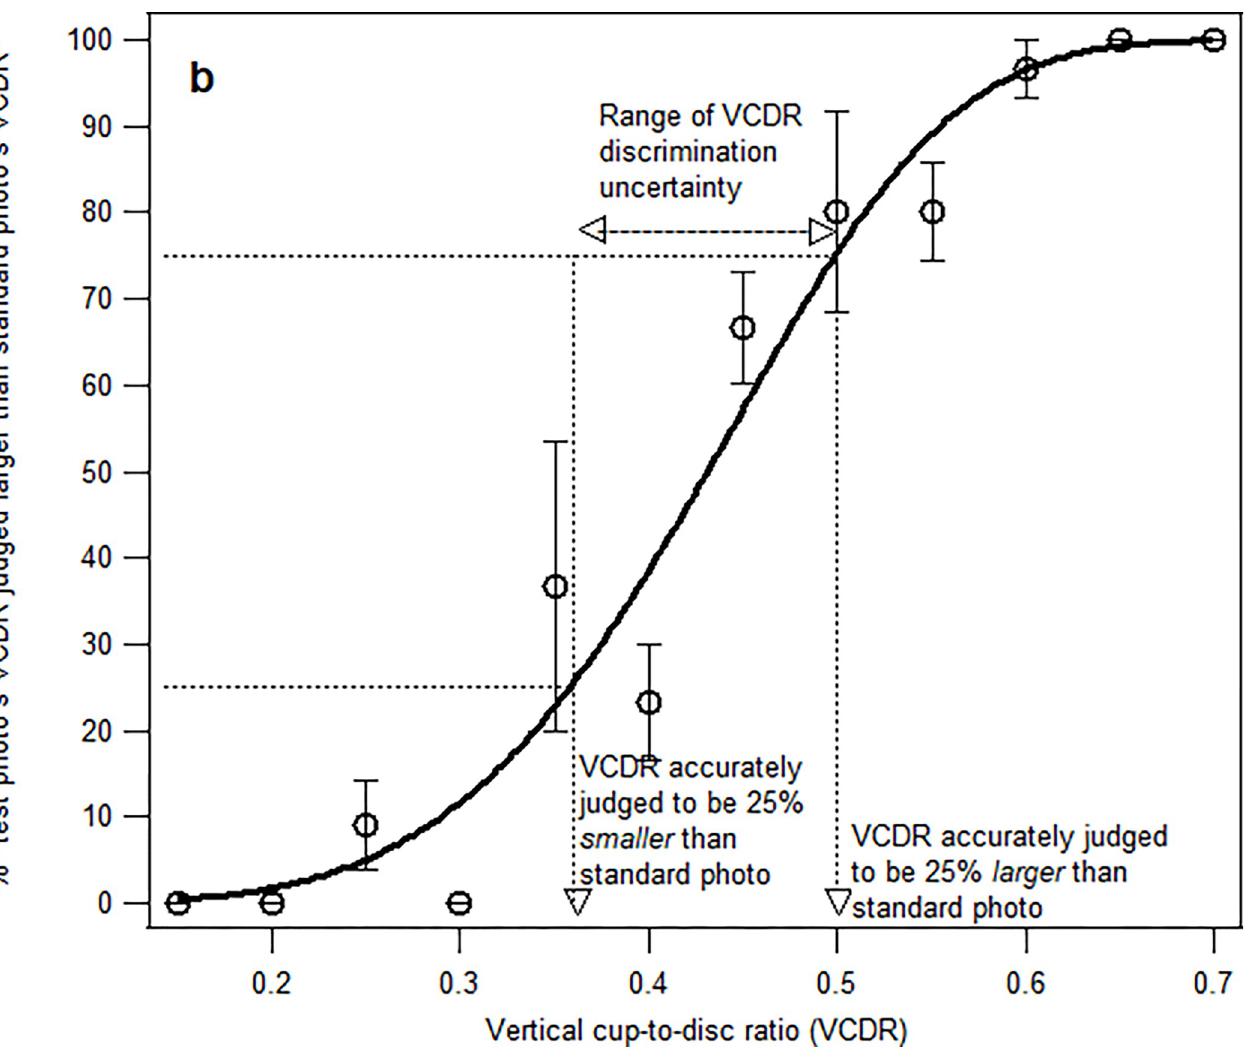
Fig 3. The range of VCDR discrimination uncertainty was calculated by subtracting the VCDR that was accurately judged to be 25% larger than the standard photo’s VCDR with VCDR that was accurately judged to be 25% smaller than the standard photo’s